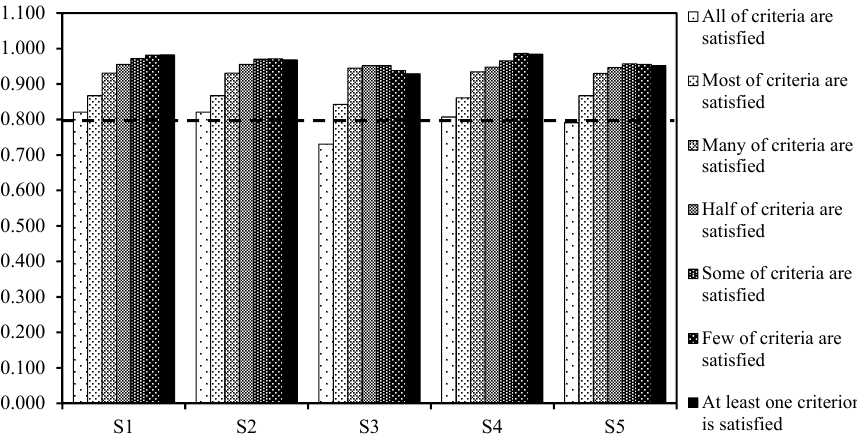
Figure 14. The EMOWA group consensus measurements of water strategies in the risk cases.